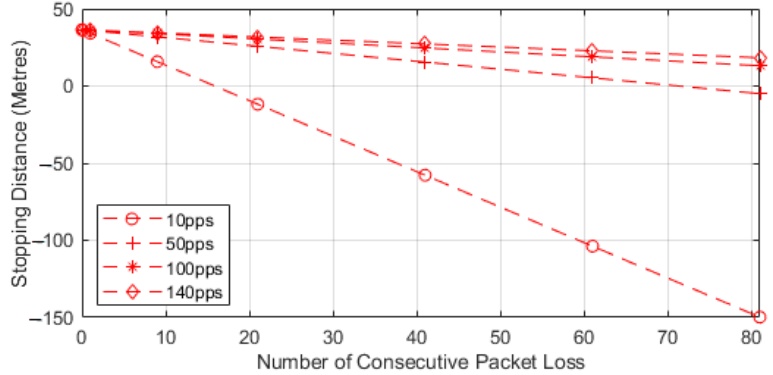
Figure 17. Fifty miles per hour (80.45 km/h) reduction in stopping